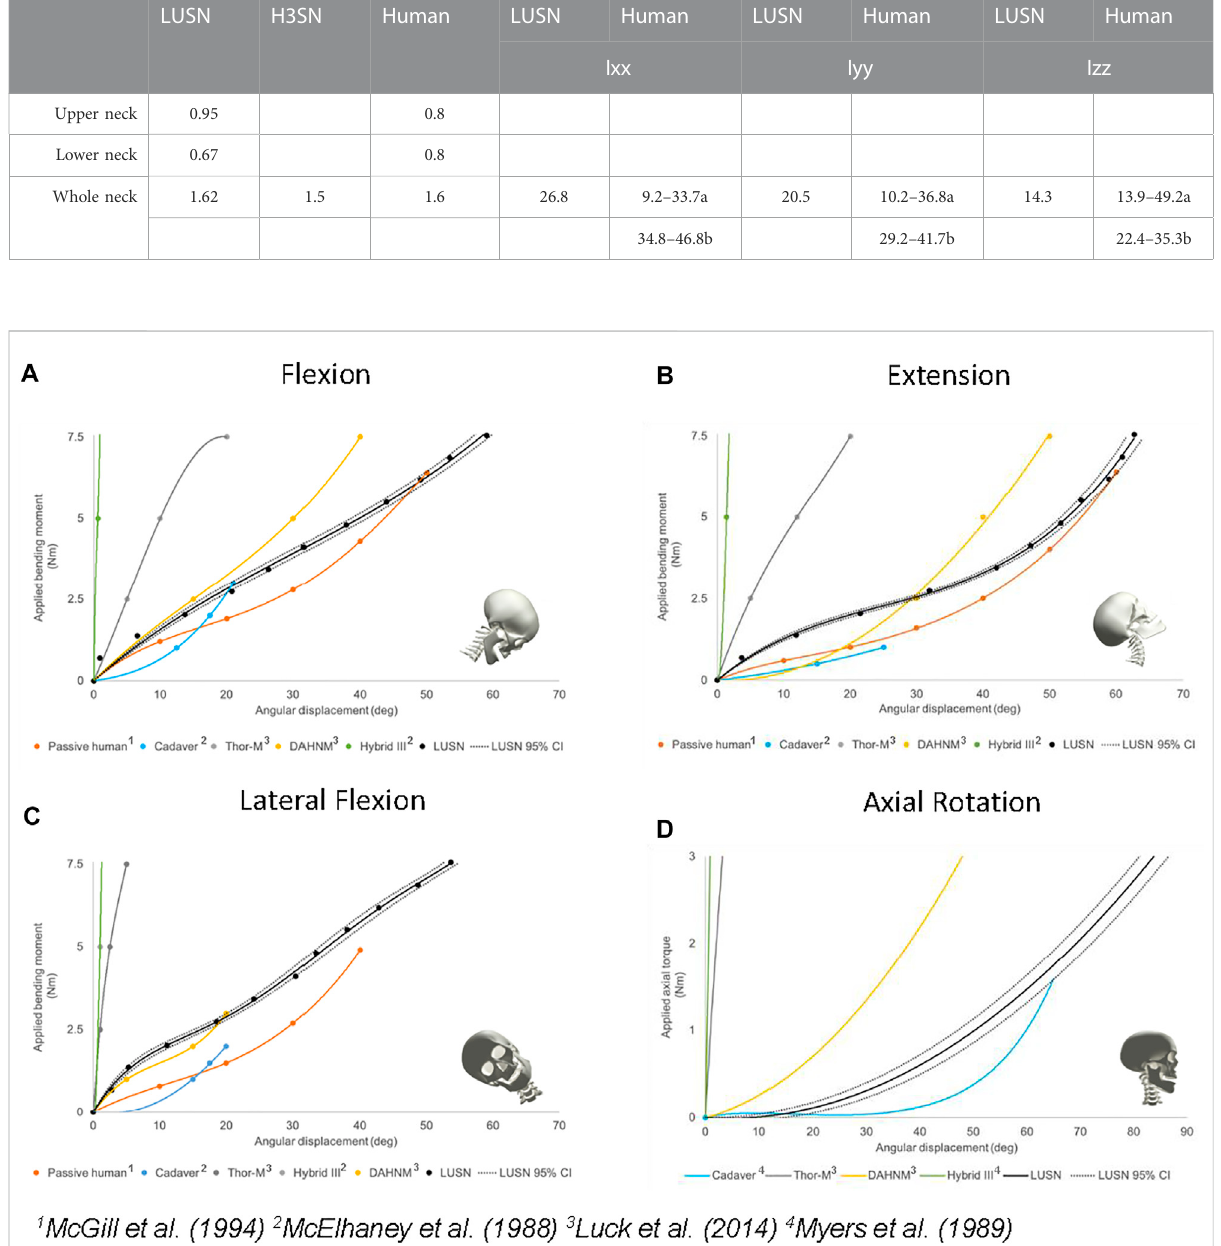
Frontiers in Bioengineering and